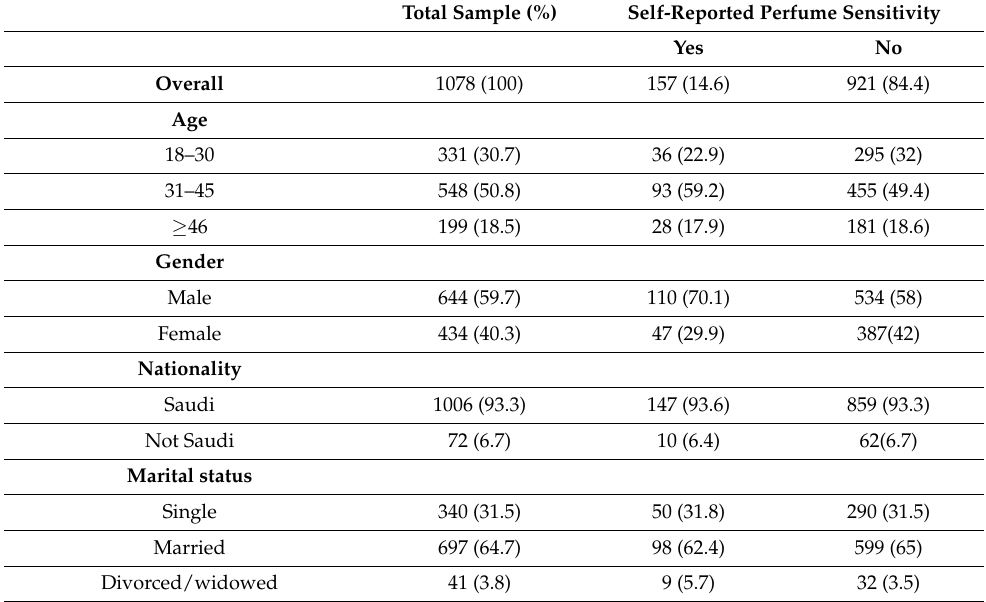
Table 1. Socio-demographic characteristics among study participants ( n =